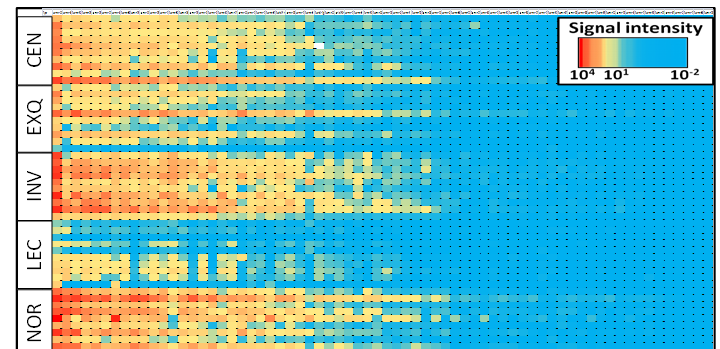
Figure 1. Heatmap analysis of multiplex miRNA assay. The color code corresponds to the signal intensity obtained in the assay, and samples were grouped by isolation method. Each square corresponds to a single miRNA and sample. CEN: ultracentrifugation; EXQ: Exoquick-TC; INV: Total Exosome Isolation Solution; LEC: lectin-based purification; NOR: Urine Exosome RNA Isolation Kit.